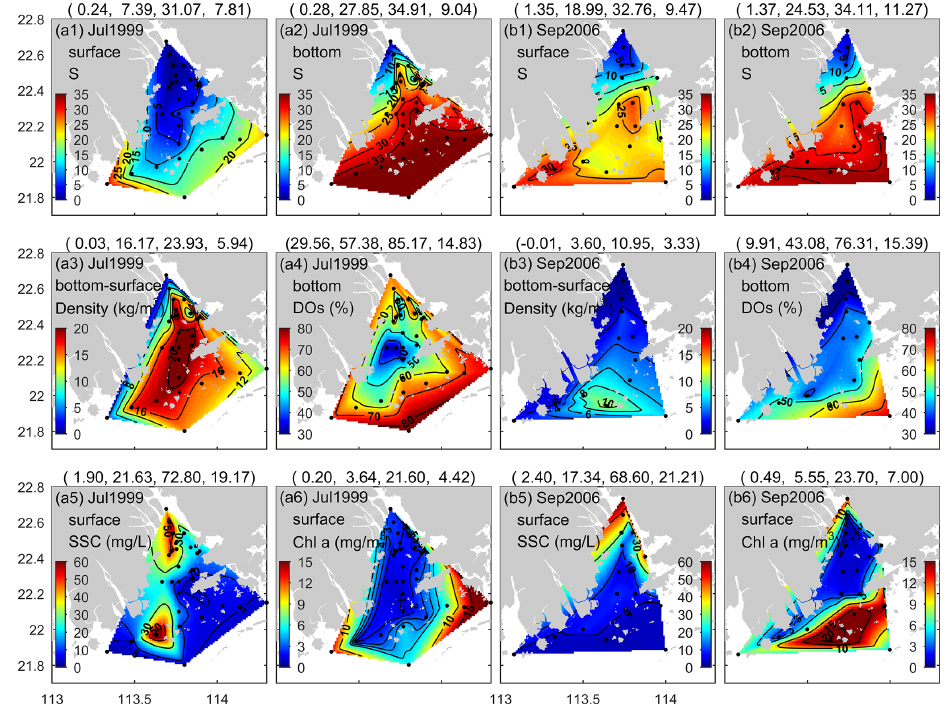
Figure 10. Comparison of water quality metrics observed in the PRE between (a) July 1999 (summer) and (b) September 2006 (early autumn): surface and bottom salinity (a1,a2,b1,b2) , vertical density difference and bottom DO saturation (DO s ) (a3,a4,b3,b4) , and surface suspended sediment concentrations (SSCs) and chlorophyll (chl) a contents (a5,a6,b5,b6) . Note that the numbers in parentheses in the titles are the minimum, mean, maximum, and standard deviation values of the associated water quality metrics in